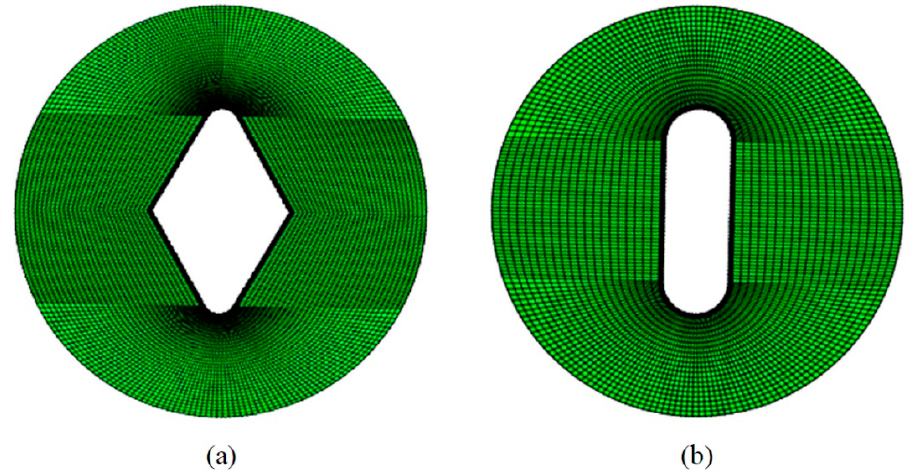
Figure 6. Examples of mesh patterns: ( a ) V-notched specimen (2 α = 60°); ( b ) U-notched specimen.